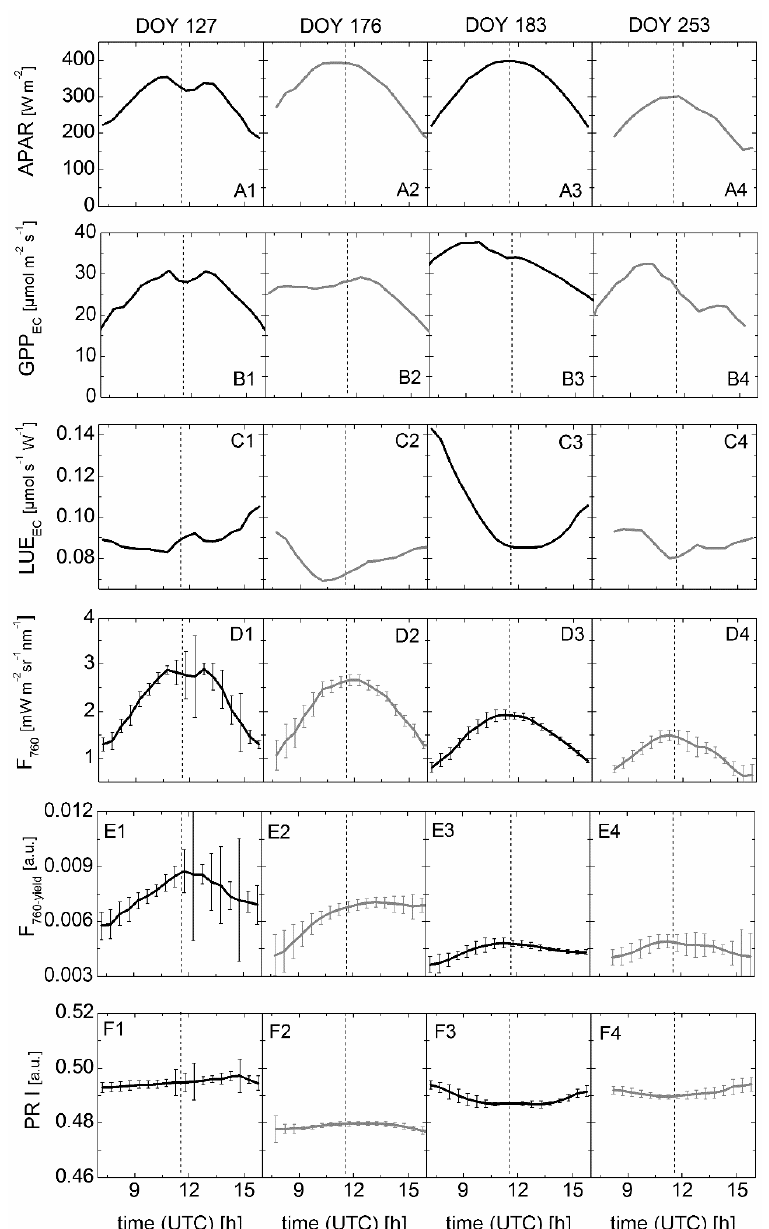
Figure 4. Diurnal behavior of canopy variables measured on the ground in a winter wheat field on DOY 127 and 176 and in a sugar beet field on DOY 183 and 253. Top row ( A1 – A4 ): Photosynthetically active radiation absorbed by the canopy (APAR); Second row ( B1 – B4 ): Gross primary productivity derived from the eddy covariance (EC) measurements (GPP EC ); Third row ( C1 – C4 ): Light-use efficiency of photosynthetic CO 2 uptake derived from the EC data (LUE EC ); Fourth row ( D1 – D4 ): Sun-induced chlorophyll fluorescence (F 760 ) obtained from ground-based spectroscopy measurements; Fifth row ( E1 – E4 ): Sun-induced chlorophyll fluorescence yield (F 760-yield ) obtained from ground-based spectroscopy measurements; Bottom row ( F1 – F4 ): Photochemical reflectance index (PRI) obtained from ground-based spectroscopy measurements. Vertical dashed lines indicate the solar noon. Vertical error bars indicate the standard deviation ( n = 200 single measurements within a 30 min time window, rows D to E ).